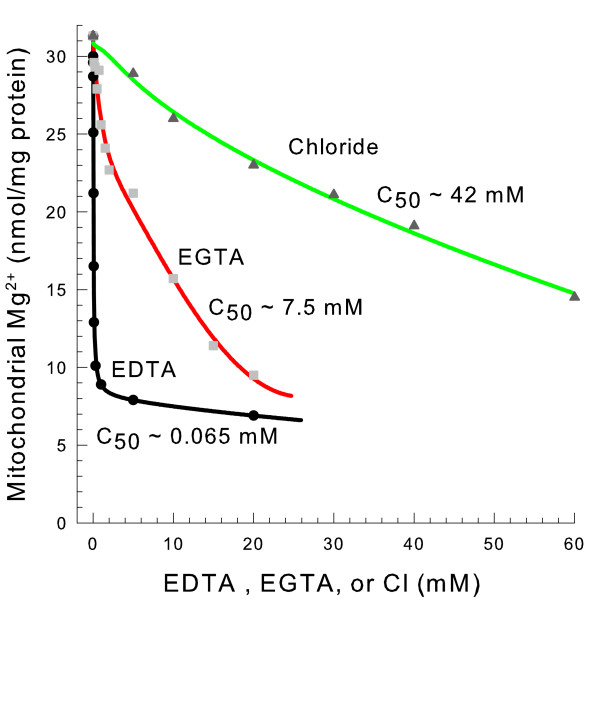
EDTA stimulates mitochondrial Mg2+ efflux much more potently than EGTA. The medium contained 0.6 M mannitol, 10 mM HEPES (TEA+), pH 7.20, and 0.1 mM decavanadate (Na+). TEA EDTA, TEA EGTA, and TEA Cl were present as shown. Timepoints were taken at 20 minutes.